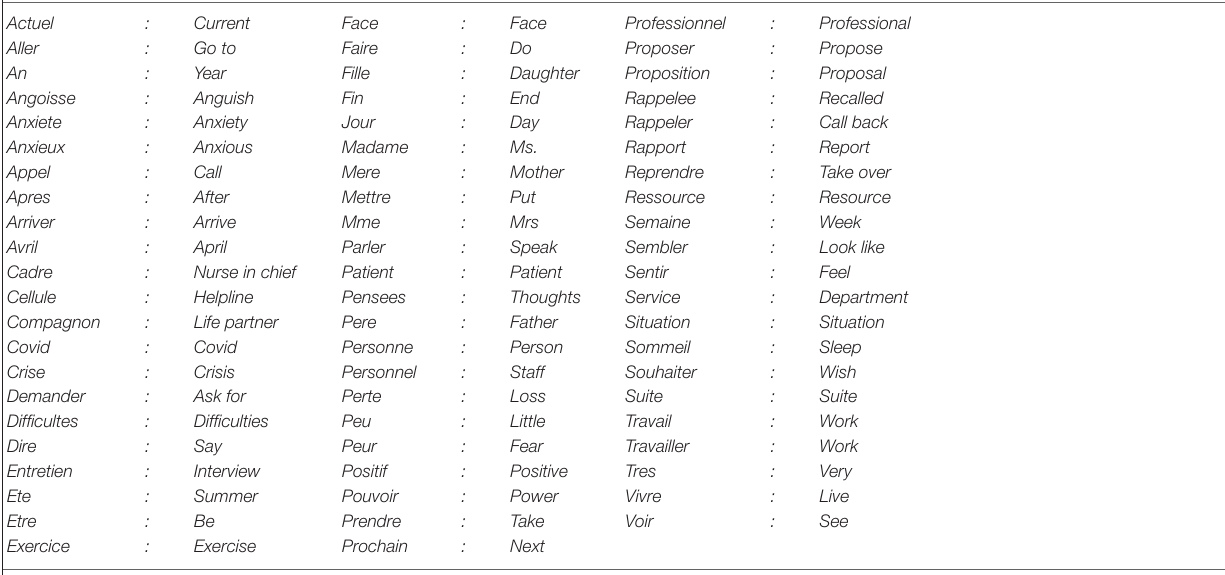
Frontiers in Psychiatry |